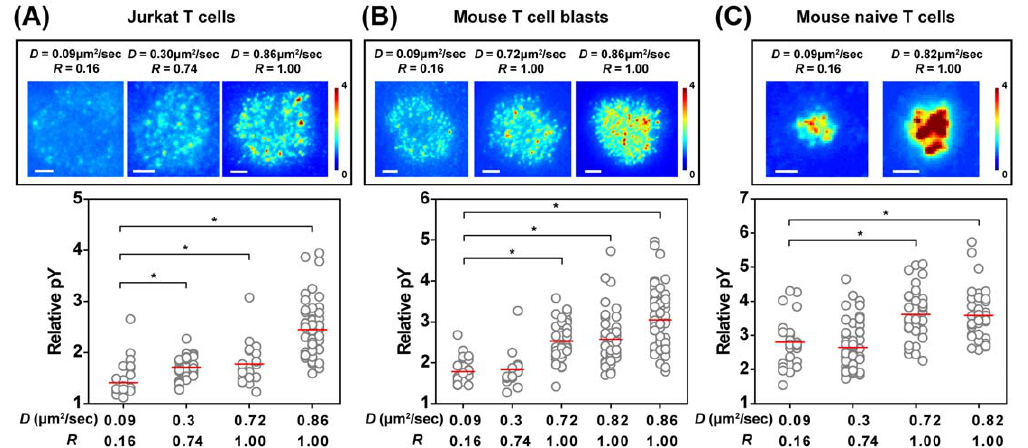
Figure 6. High ligand mobility promotes elevated phosphotyrosine responses. (A) Jurkat cells (B) mouse T cell blasts, and (C) mouse naı¨ve T cells were stimulated on the indicated bilayer surfaces coated with OKT3, ICAM-1 + 2C11, or ICAM-1 + pMHC, respectively. Cells were fixed at 5 min after cell contact, fluorescently labeled for phosphotyrosine, and imaged by TIRF microscopy. Relative phosphotyrosine intensity was determined and depicted as a heat map. Representative cells are shown (top). Scale bars=3 m m. Relative phosphotyrosine levels in multiple cells were plotted as a function of D and R (bottom), with horizontal red lines indicating average values. Asterisks represent p less than 0.002 compared to low mobility membranes. N . 25 cells per condition.